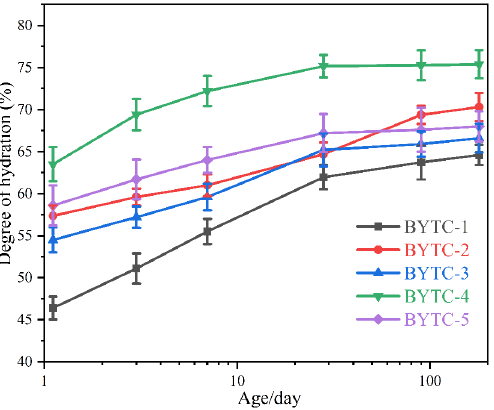
Figure 7. Hydration degree of BYT cement (measurement error is ±2%).